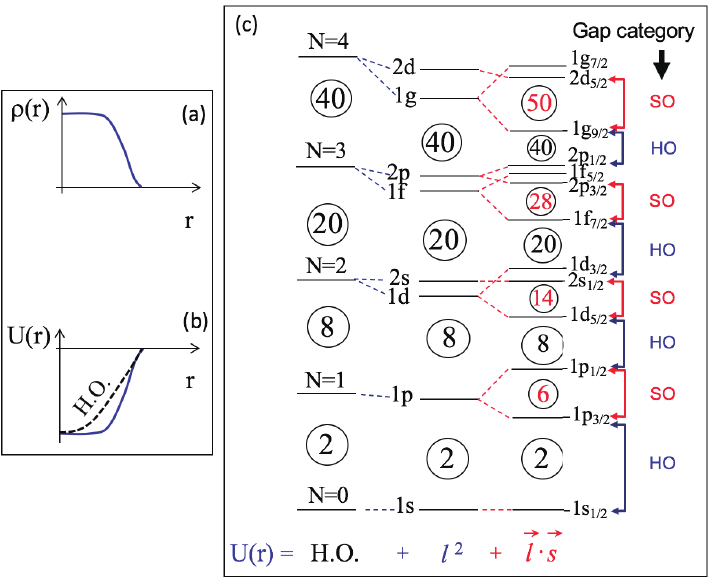
Figure 1. Schematic illustration of ( a ) density distribution of nucleons in atomic nuclei, ( b ) a mean potential (solid line) produced by nucleons in atomic nuclei and an approximation by a Harmonic Oscillator (HO) potential (dashed line). The abscissa, r , implies the radius from the center of the nucleus. ( c ) The shell structure produced with resulting magic numbers in circles. Left column: only the HO potential is taken with HO quanta shown as N = 0, N = 1, ...(N here does not mean the neutron number, N .) Middle column: the (cid:96) 2 term is aded to the HO potential, where the magic gaps are shown in circles. The single-particle orbits are labeled in the standard way to the left. Right column: the spin-orbit term, ( (cid:126) l · (cid:126) s ) , is included further, and magic gaps emerging from this term are shown in red. The single-particle orbits are labeled to the right, including (cid:126) j = (cid:126) l + (cid:126) s . The magic gaps are classified as “HO” and “SO” for the HO potential and spin-orbit origins, respectively. Taken from Figure 2 of [15], which was based on